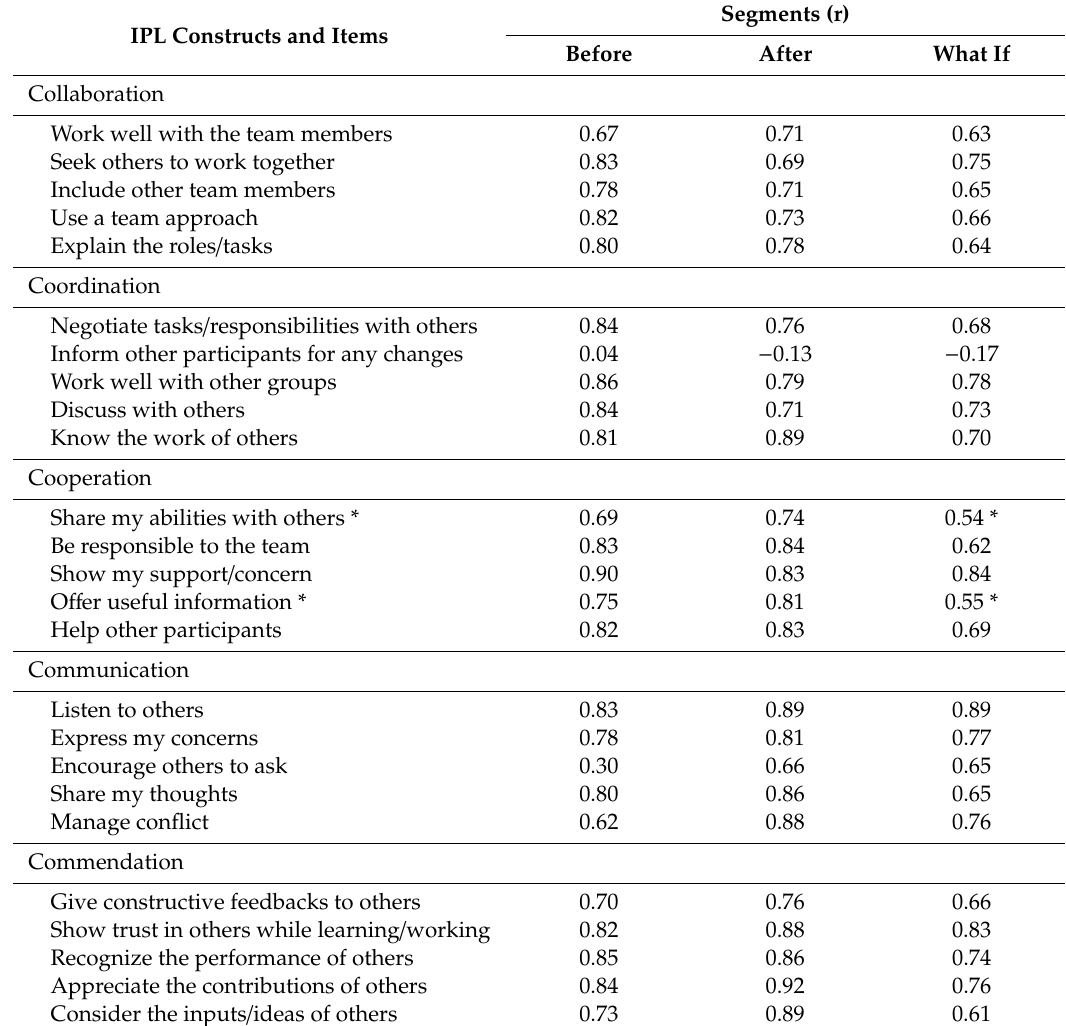
Table 7. Item-total validity ( n =